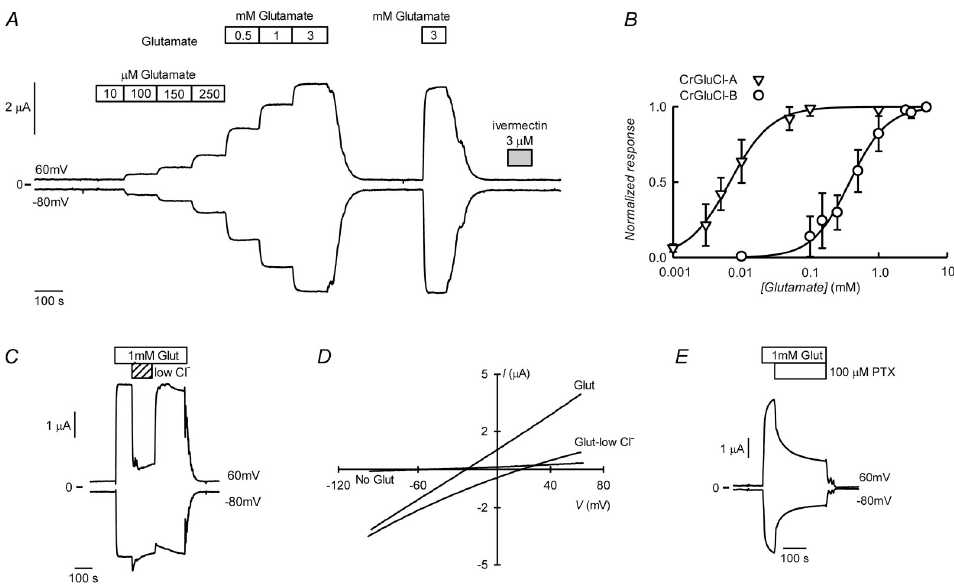
Fig 3. Glutamate-activated currents of CrGluCl-B cRNA-injected Xenopus oocytes. A. Current traces obtained at the indicated membrane potentials during bath application of glutamate at concentrations from 10 μ M to 3 mM, or 3 μ M ivermectin during the times shown in the boxes. B. Plot summarising results of the concentration-response relationship of the glutamate-sensitive currents mediated by CrGluCl-B. The responses were normalised to the maximal effect evoked by glutamate. The lines are Hill equations fitted to the data sets which are means ± SD with n = 16 for CrGluCl- B. Data for CrGluCl-A (n = 5) are from experiments performed contemporarily. C. Chloride -dependence of 1 mM glutamate-evoked current. D. Current voltage relations taken from voltage-ramps applied during the experiment shown in panel C. The graph shows a current-voltage relation before addition of glutamate (No Glut), in the presence of glutamate (Glut) and in low chloride extracellular solution. E. Effect of 100 μ M PTX on glutamate-activated currents mediated by CrGluCl-B.